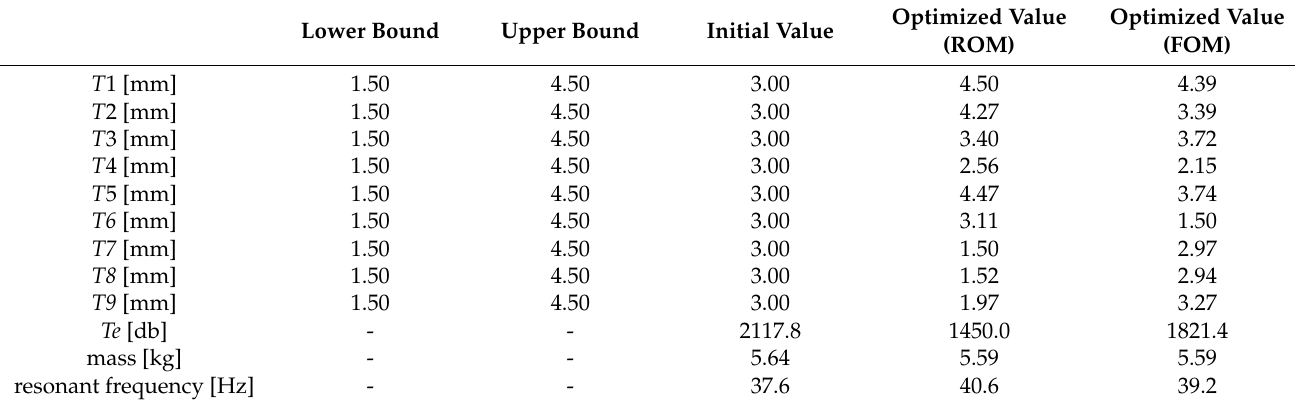
Table 3. Vibration reduction optimization results of